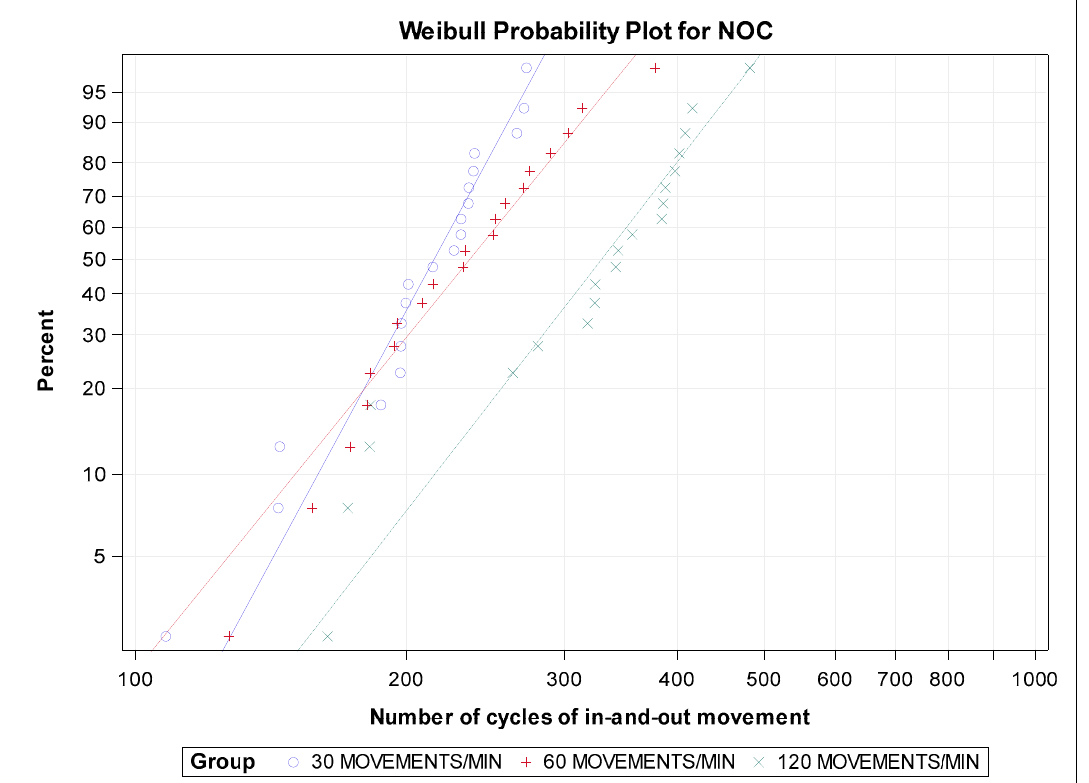
Figure 8. Boxplots of the number of cycles of in-and-out movement of the experimental groups. The horizontal line in each box represents the median value.